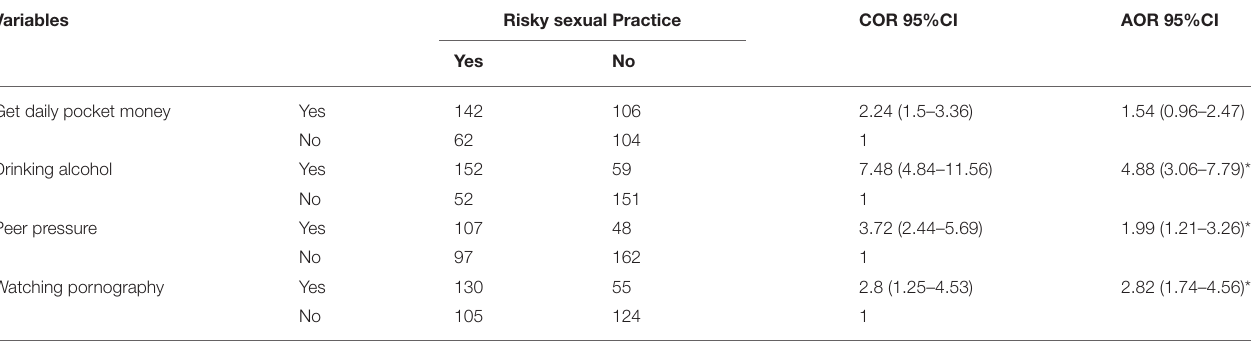
TABLE 4 | Bivariable and multivariable logistic regression analysis of factors associated with risky sexual practice among preparatory school students, in Gondar city, northwest Ethiopia, 2019.